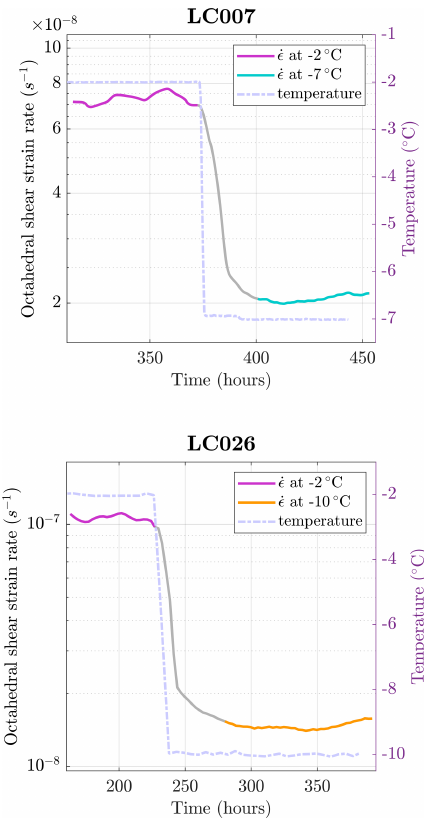
Figure 2. Plots of octahedral shear strain rate vs. time for (a) LC007 ( − 2 to − 7 ◦ C) and (b) LC026 ( − 2 to − 10 ◦